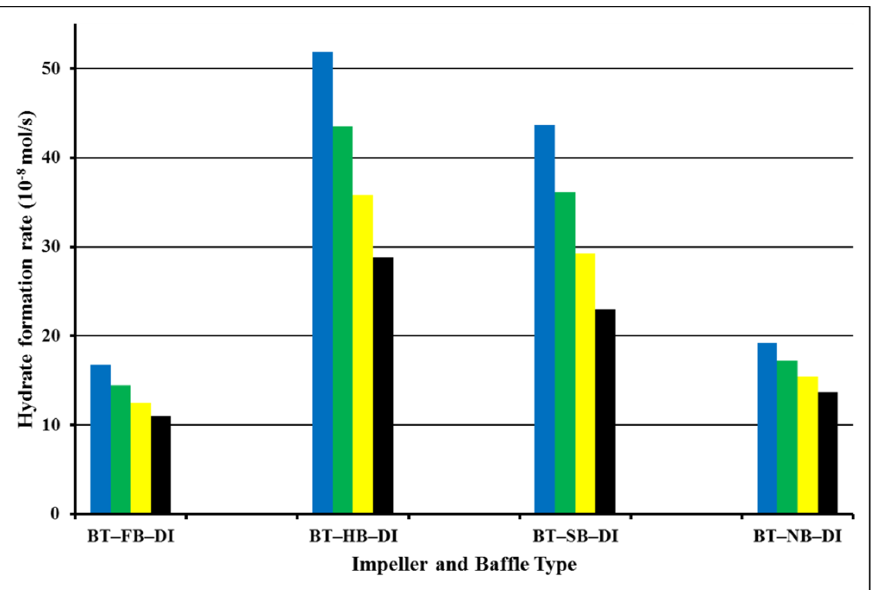
Figure 4. Rate of hydrate formation in dual ‐ impeller experiments at starting rotation properties 2 °C and 42.5 bars for 1 s (blue), 600 s (green), 1200 s (yellow), and 1800 s (black). Hydrate formation rates of BT experiments with full baffles are always lower than hydrate formation rates of BT experiments with half, surface, or no baffle, which is the same as in a single experiment. The highest value of the rate of hydrate formation was 51.9 × 10 − 8 mol/s for a full baffle, and next was the surface ‐ baffle experiment with a value of the rate of hydrate formation at 43.7 × 10 − 8 mol/s. The experiment with a full baffle had the lowest value of the rate of hydrate formation, 16.7 × 10 − 8 mol/s, which was quite close to a no ‐ baffle experiment value which was 19.2 × 10 − 8 mol/s. This shows that the short length of the central vortex that was created functioned positively in our system, while no vortex or a lengthy vortex function negatively. These outcomes show that BT experi ‐ ments with half and surface baffle create better interactions between gas and liquid compared with the other two experiments, showing a behavior which nominates a better level of gas–liquid contact. Mass transfer impedances could be perceptibly reduced which finally leads to beneficial mixing intensity [26,27]. It should be noticed from the last column of Table 1 that the repeated (duplicated) experiments had almost the same rate of hydrate formation ranging from 1.25 to 1.92 for the first second and from 1.01 to 1.35 for 600 s, confirming our experiments in both the single ‐ and dual ‐ impeller experi ‐ ments. Figure 5 shows the number of moles of free gas with the time for dual impellers.